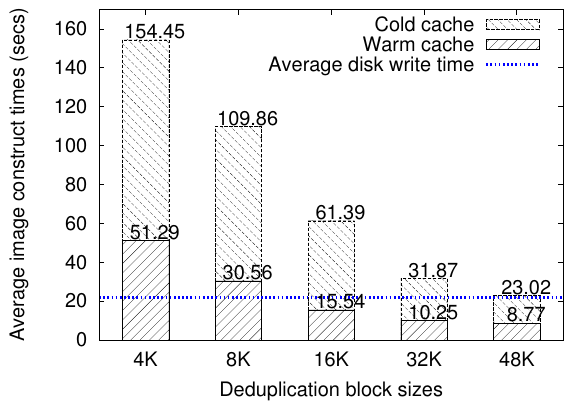
Figure 6: Average image-construction time for different Venti block sizes.